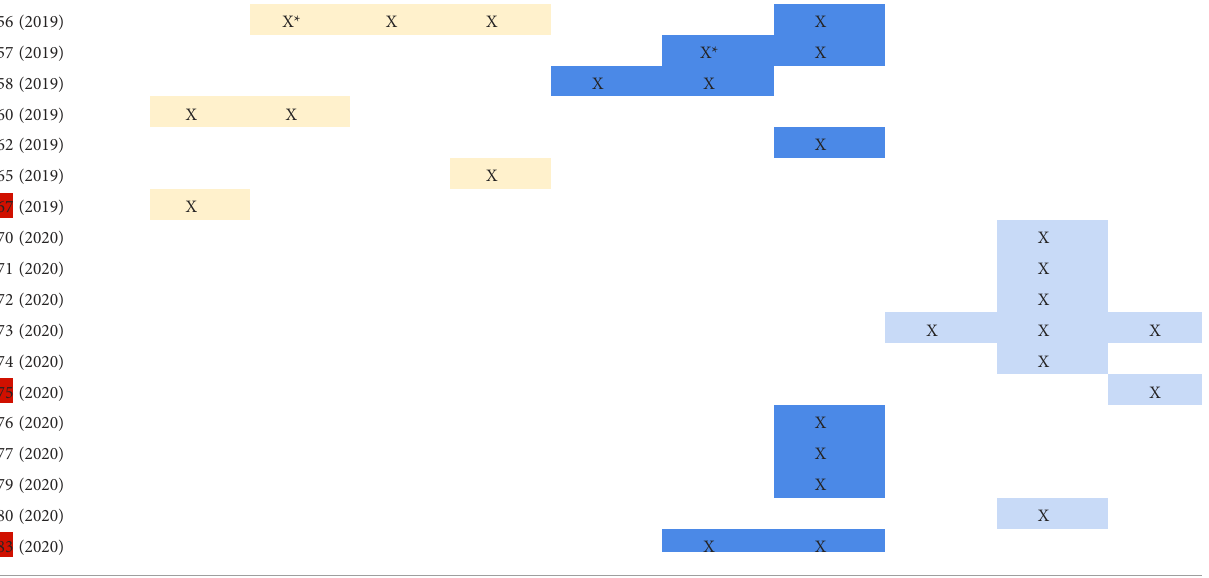
(Supplementary Table 1). For the 2019 F1s, smaller branch clips of 5-8 polyps were taken and for the 2020 F1s, 2-4 polyps were scraped into ethanol. Samples were stored at 4°C